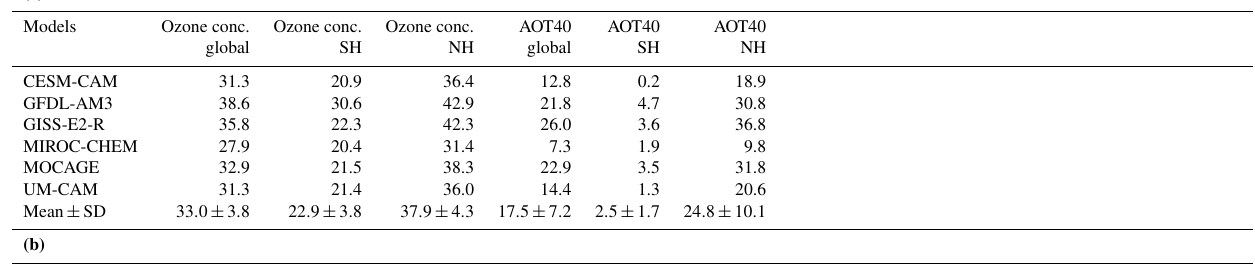
Table 3. (a) Global and hemispheric (averaged over the land points of the domain) mean annual-average surface ozone concentrations (in ppb) and mean AOT40 (in ppmh) for the historical simulations in each model (Northern and Southern hemispheres, i.e. NH and SH). The last row shows means and SDs. (b) Simulated percentage (%) changes in global and hemispheric mean annual-average surface ozone concentrations (over the land points of the domain) and in global mean stratospheric ozone column ( ∗ from Voulgarakis et al., 2013) for each model between 2100 and historical simulation for RCPs (NH and SH). The last row shows means and SDs. Missing or not available data are identified (n.a.). (c) Simulated percentage (%) changes in global and hemispheric mean AOT40 (over the land points of the domain) for each model between 2100 and historical simulation for RCPs (NH and SH). Missing or not available data are identified (n.a.). (d) Simulated percentage (%) changes in potential O 3 impact on vegetation (IO 3 , over the land points of the domain) for each model between 2100 and historical simulation for RCPs (NH and SH). Missing or not available data are identified